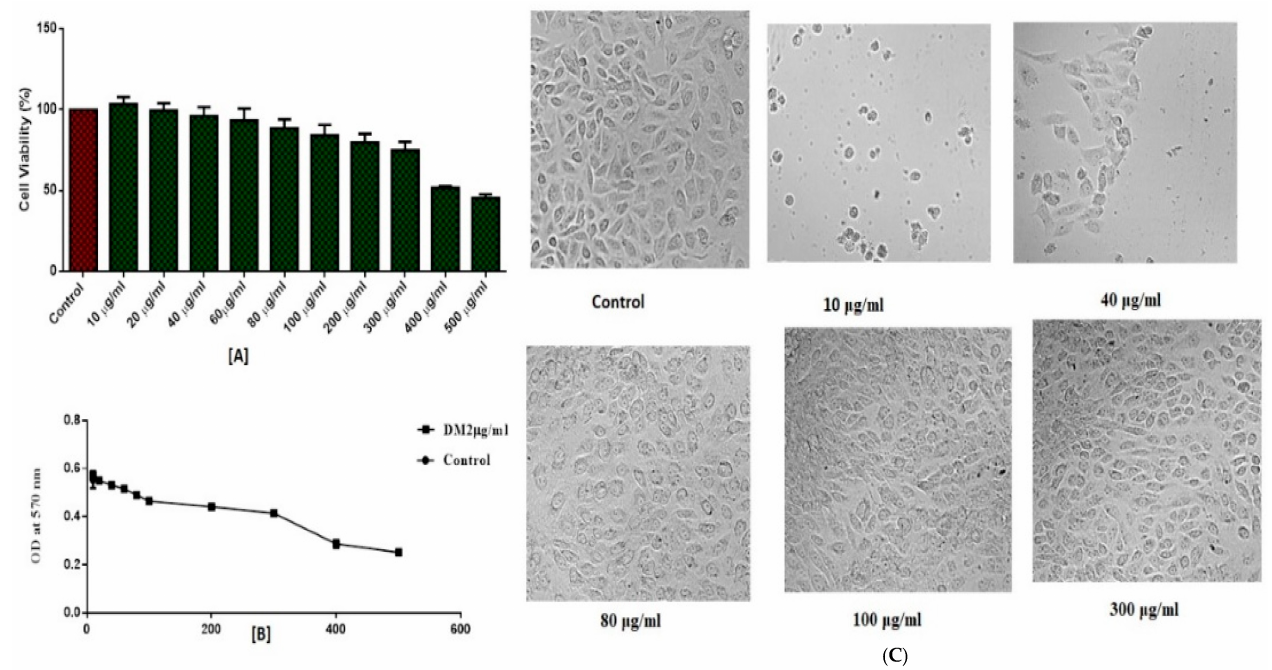
Figure 5. Effect of DM2 on Vero cell viability. ( A ) Cell viability; ( B ) A dose-response curve and IC 50 ; ( C ) Morphological observation of Vero cells with different concentrations under phase contrast microscope after 48 h exposure.